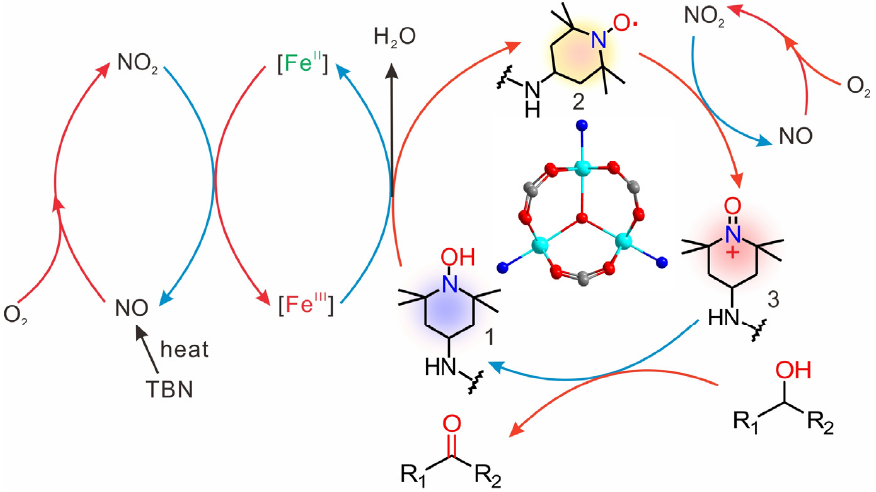
Figure 5. A plausible catalytic mechanism for the aerobic oxidation of alcohols by MIL-101(Fe)/TEMPO-IsoNTA.